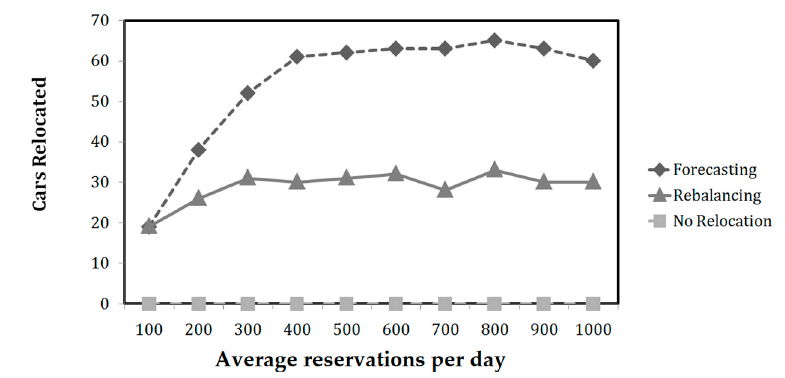
Figure 8. Effect of the number of reservations on relocation cost.